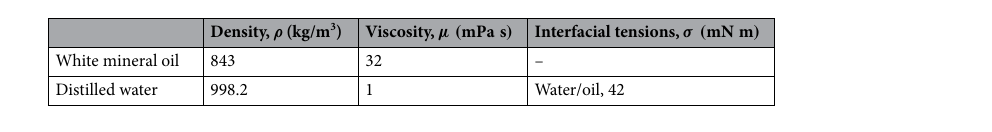
Figure 1. Schematic drawing of the flow loop used in this study.